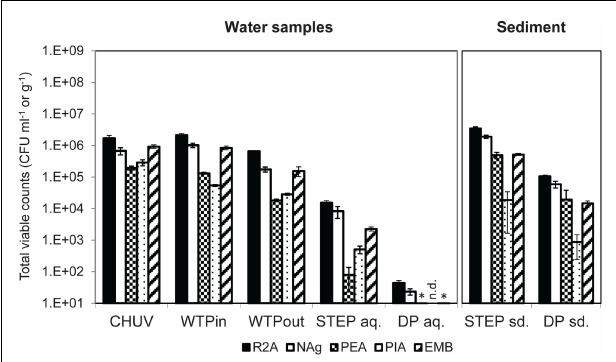
FIGURE 2 |Total viable counts, normalized to sample volume or mass, on agar media without antibiotics. An asterisk ( ∗ ) indicates less than 10CFUml − 1 . n.d., no colonies detected. Error bars indicate standard deviation of triplicate platings of the same sample.